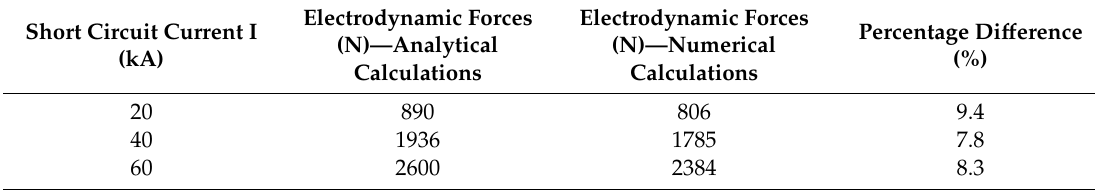
Table 4. Comparison of the results for selected short circuit